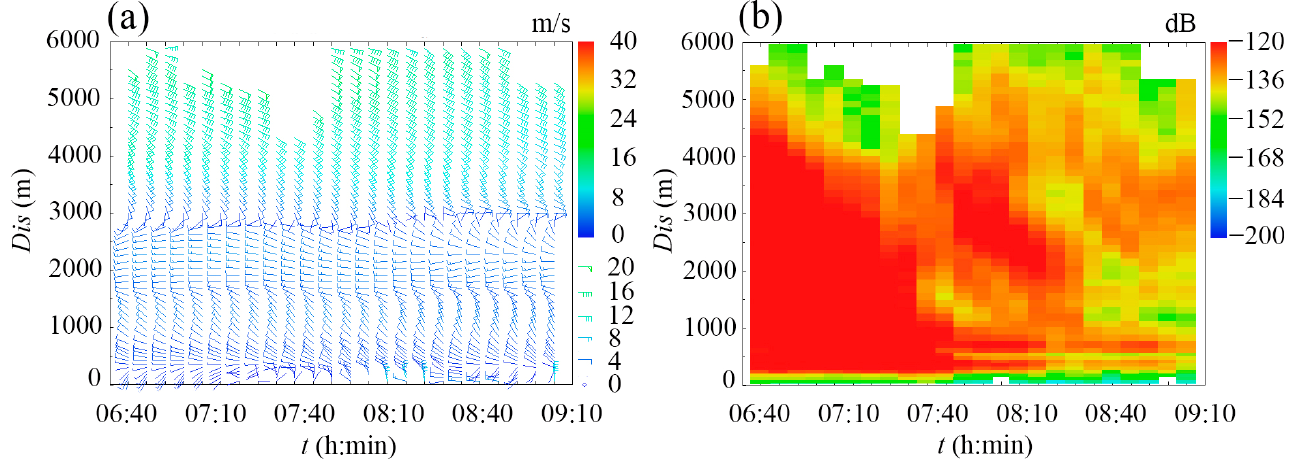
Figure 5. Temporal evolution of ( a ) wind speed and ( b ) atmospheric refractive index ( cn 2 ) measured by WPR in the zenith direction of the field site. by WPR in the zenith direction of the field